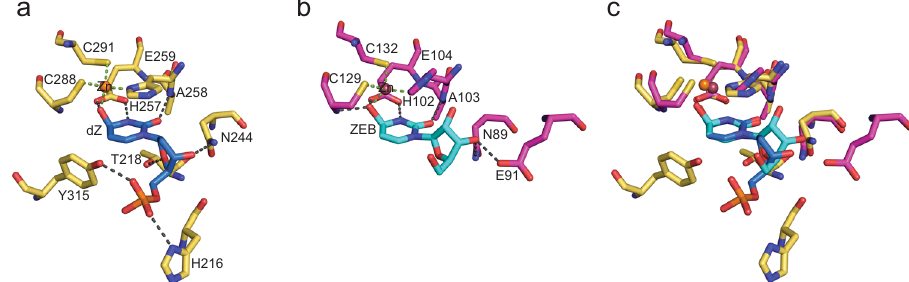
Fig. 4 |ComparisonofinteractionsbetweenthecatalyticsiteofA3G-CTD2 and shown as a raspberry sphere. C, N, S and O atoms are colored magenta, navy blue, E. coli CDA. a Active site interactions of A3G-CTD2 with the 2 ′ -deoxy-zebular- gold and red, respectively, for amino acid residues of the protein. Atoms in inehydratedintermediate(dZ-H 2 O)(PDB7UXD).Zn 2+ isshownasanorangesphere. nucleotides are colored cyan, navy blue and red for C, N and O respectively. c Superimposition of the 2 ′ -deoxy-zebularine hydrated intermediate (dZ-H 2 O) C, N, S and O atoms are colored yellow, navy blue, gold, and red, respectively, for and the ribo-zebularine hydrated intermediate (ZEB-H 2 O). Conserved amino acid amino acid residues of the protein. Atoms in nucleotides are colored blue, navy residues are shown as stick blue,red,andorangeforC,N,O,andP,respectively. b Activesiteinteractionsof E. coli CDAwithribo-zebularine-hydratedintermediate(ZEB-H 2 O)(PDB1CTU).Zn 2+ is